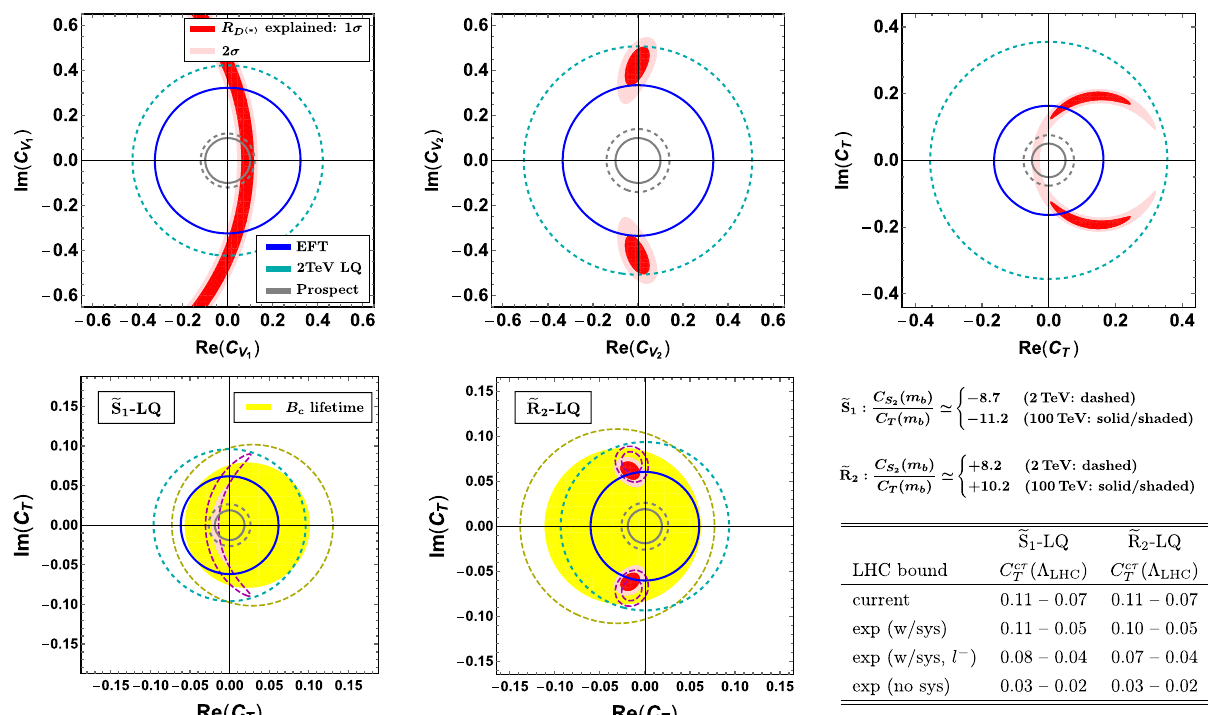
Fig. 5 The R D ( ∗ ) favored region (red: 1 σ /light-red: 2 σ ) on the com- plex plane of C c τ superimposing the LHC bounds at 95%CL for the X EFT, 2TeV LQ, and future prospects shown in blue, cyan, and gray,